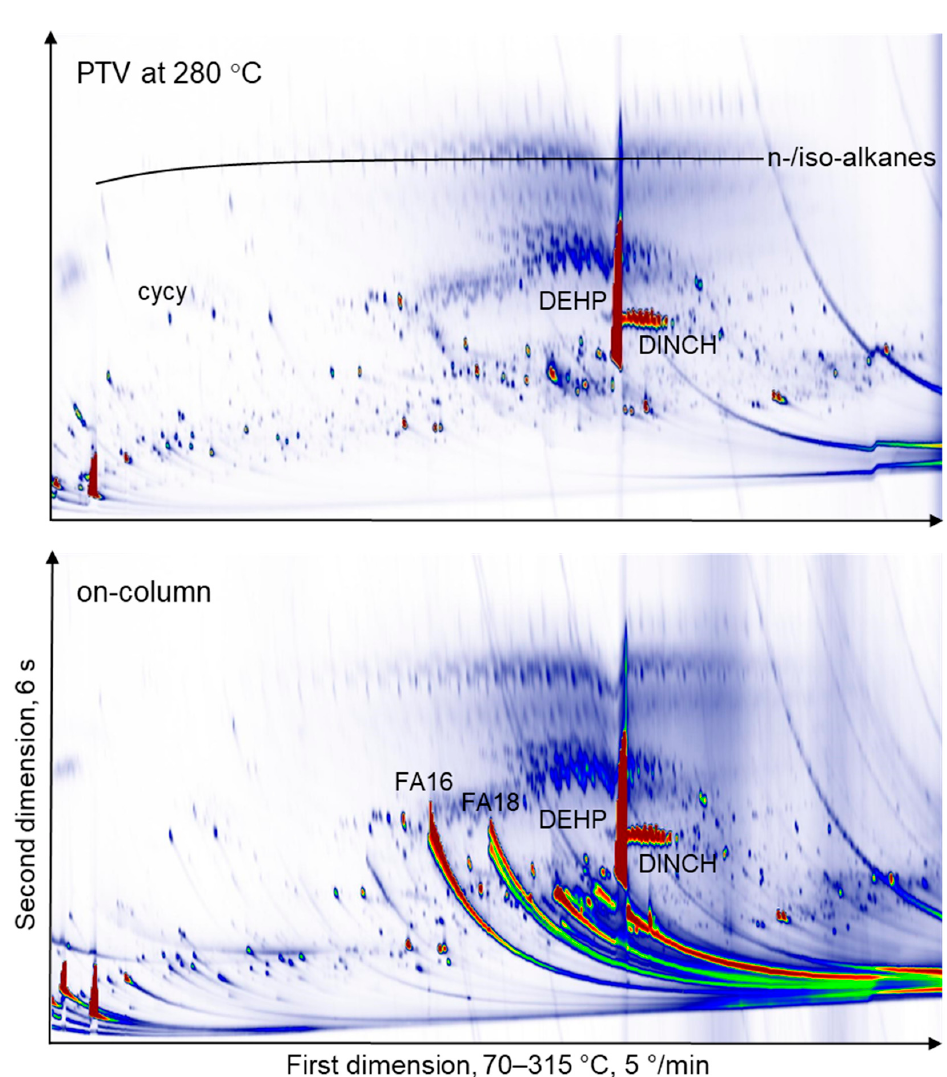
Figure 2. GC × GC-FID (comprehensive two-dimensional gas chromatography coupled with flame ionisation detection) chromatograms of tetrahydrofuran (THF) extract of acrylonitrile butadiene rubber (NBR, #4). The top panel was run with programmable temperature vaporiser (PTV) injection, while for the bottom panel, the extract was injected on-column, leading to more intense peaks of some polar components such as palmitic (FA16) and stearic acid (FA18). A large number of additional peaks are not present in the top panel, which stem from substances formed in the hot PTV injector. cycy: Cyclohexyl cyclohexane, DEHP: Diethylhexyl phthalate, DINCH: 1,2-cyclohexane dicarboxylic acid diisononyl ester, FA16: Palmitic acid, FA18: Stearic acid.